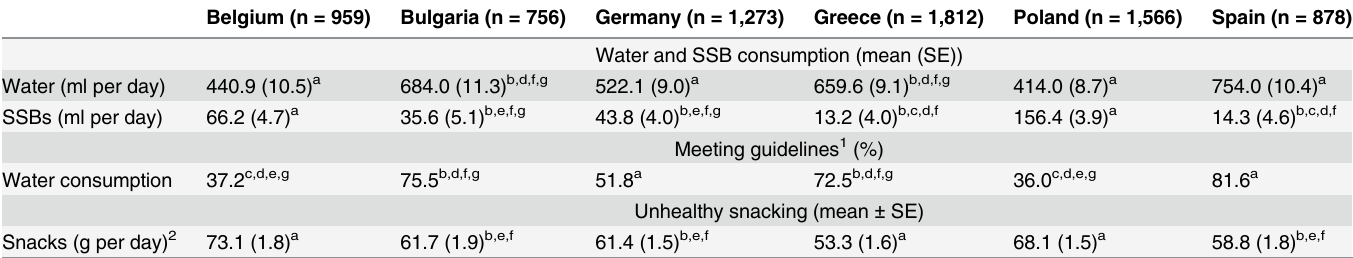
Table 6. Levels of water and sugar-sweetened beverage consumption and snacking in preschool children from six European countries (n = 7,244) (adjusted for sex and age).